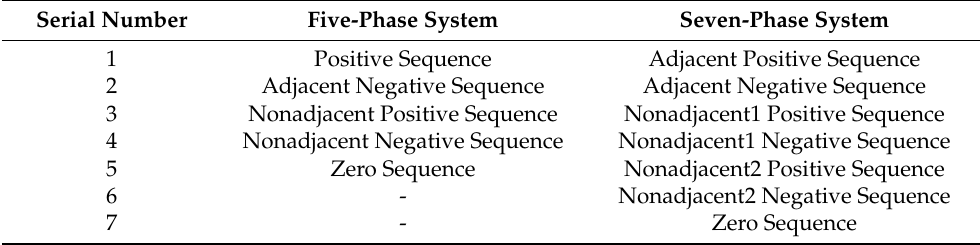
Table 7. Sequence network